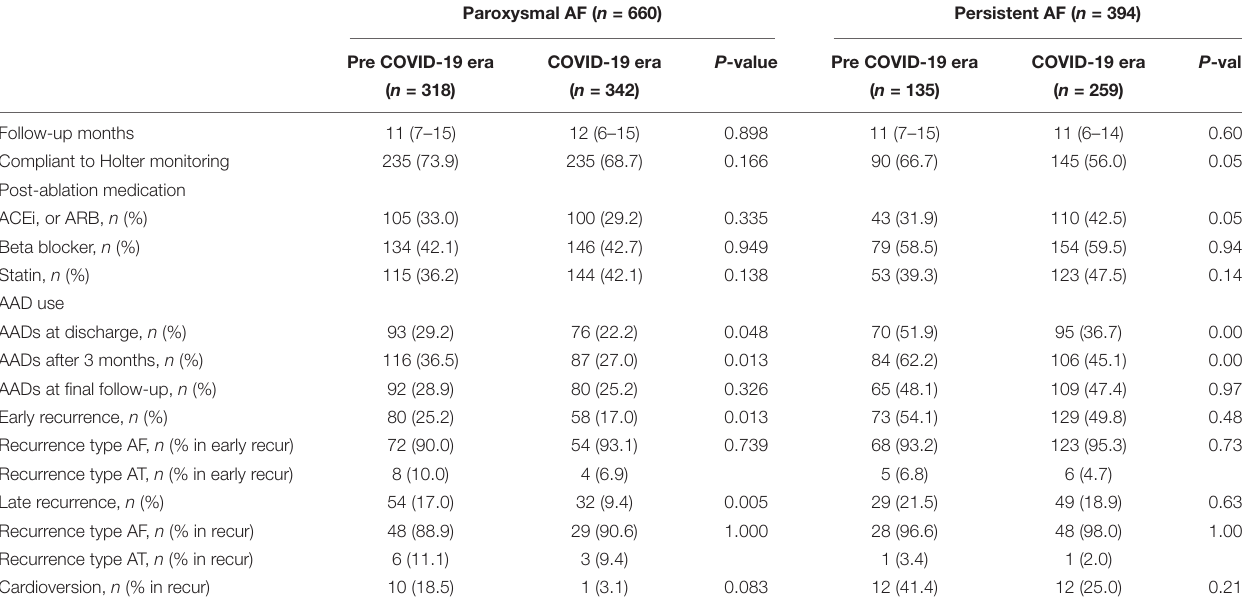
TABLE 2 | Clinical rhythm outcomes.